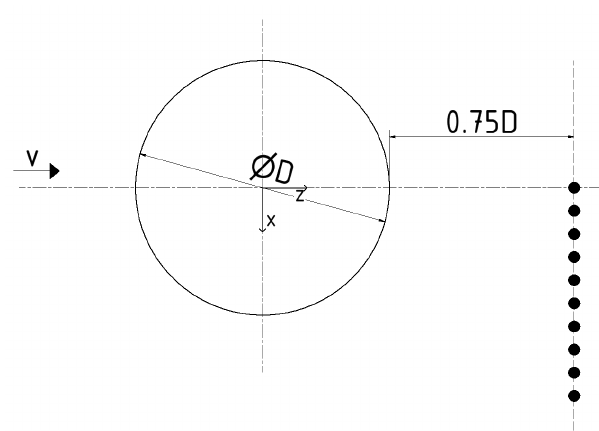
Fig. 2. Scheme of the measurement in the wind tunnel test sec- tion .